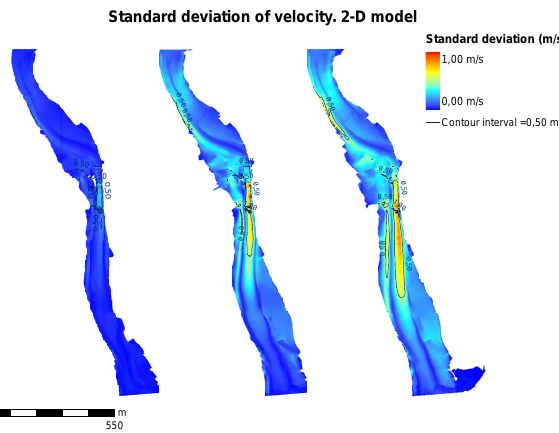
Fig. 14. 2-D SWE model. Flood maps with mean values of wa- ter depth predicted by point-estimate method for flow cases of 200m 3 s − 1 (left panel), 300m 3 s − 1 (middle panel) and 500m 3 s − 1 (right panel).